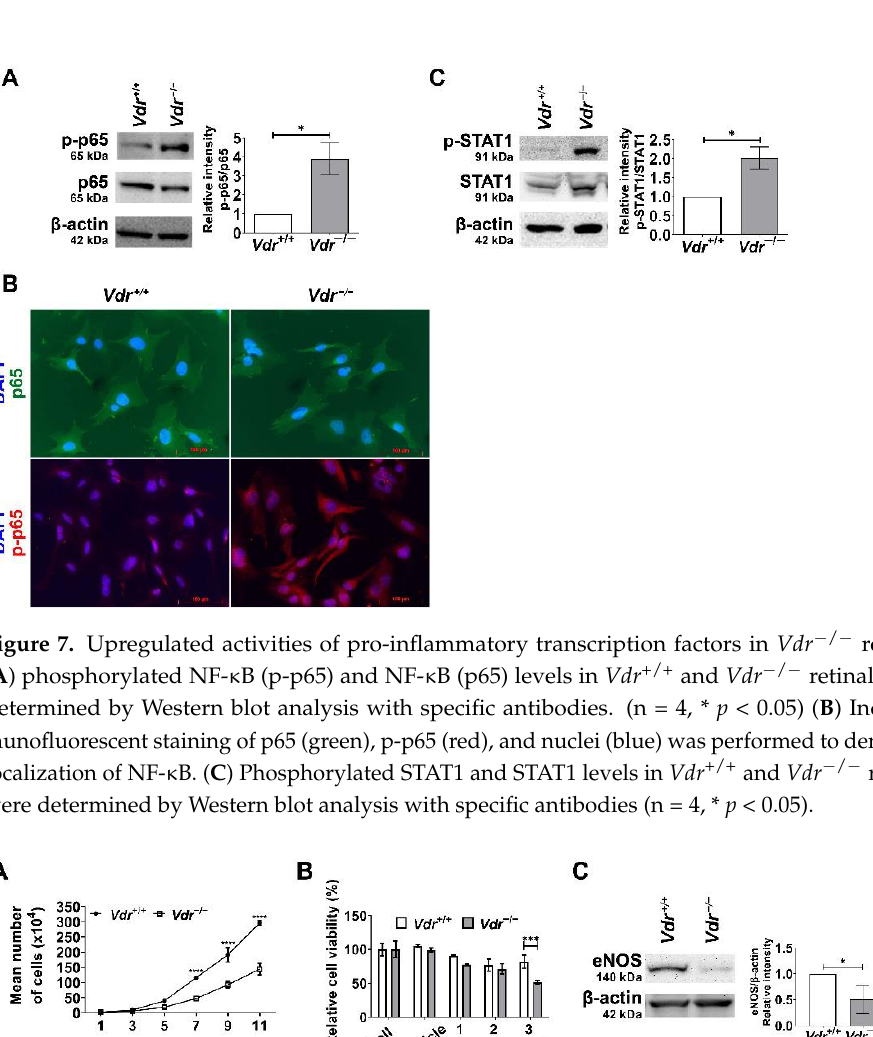
Figure 8. Altered cell proliferation and increased oxidative stress in Vdr − / − retinal EC. ( A ) The rate of Vdr +/+ and Vdr − / − retinal EC was accessed by counting the number of cells for 2 weeks as described in Materials and Methods (n = 3, **** p < 0.0001). ( B ) Sensitivity to oxidative stress induced by hydrogen peroxide (H 2 O 2 ) in retinal EC was measured by MTS assay. Vdr +/+ and Vdr − / − retinal EC were incubated with various concentrations of H 2 O 2 for 2 days in 96-well plates and subjected to the MTS assay (n = 3, *** p < 0.001). ( C ) eNOS levels in Vdr +/+ and Vdr − / − retinal EC were determined by Western blot analysis with a specific antibody (n = 4, * p <